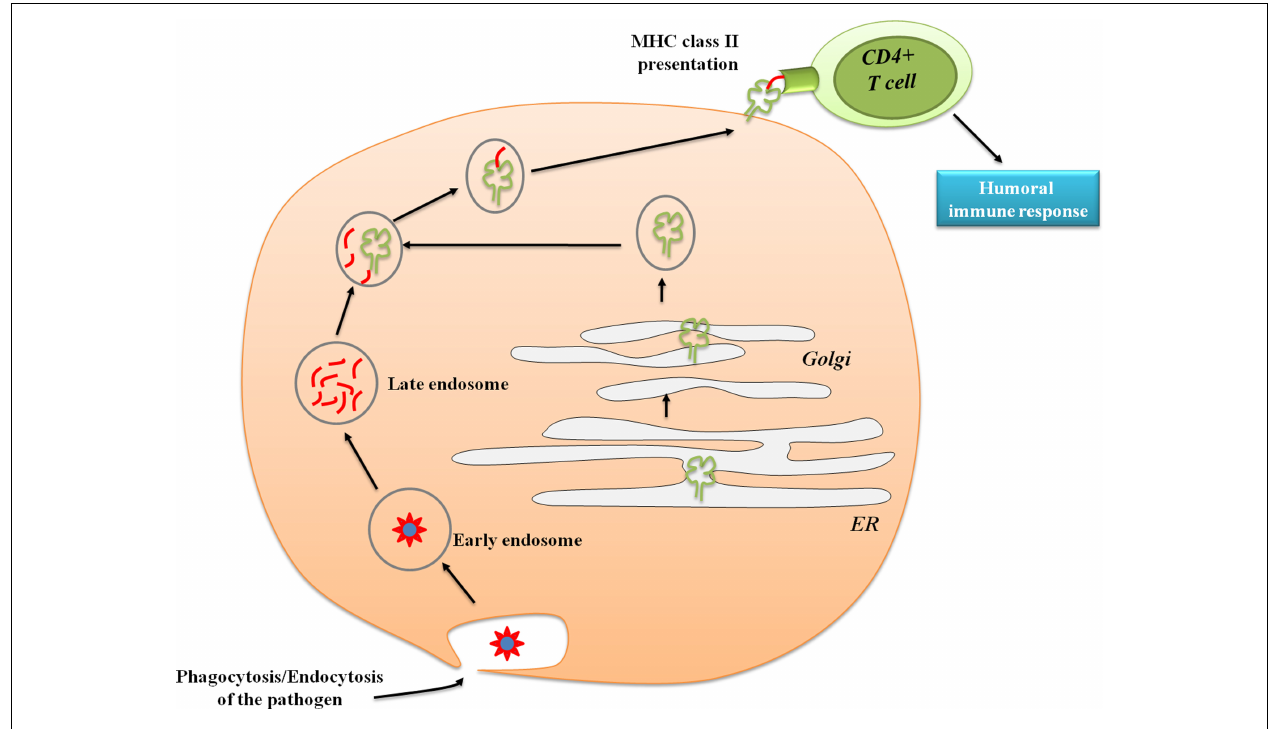
vesicles (MHC class II-enriched compartment), and the complexes are externalized to the plasma membrane. CD4 + T cells will then recognize the exogenous antigen presented by MHC class II leading to the stimulation of CD4T cells humoral